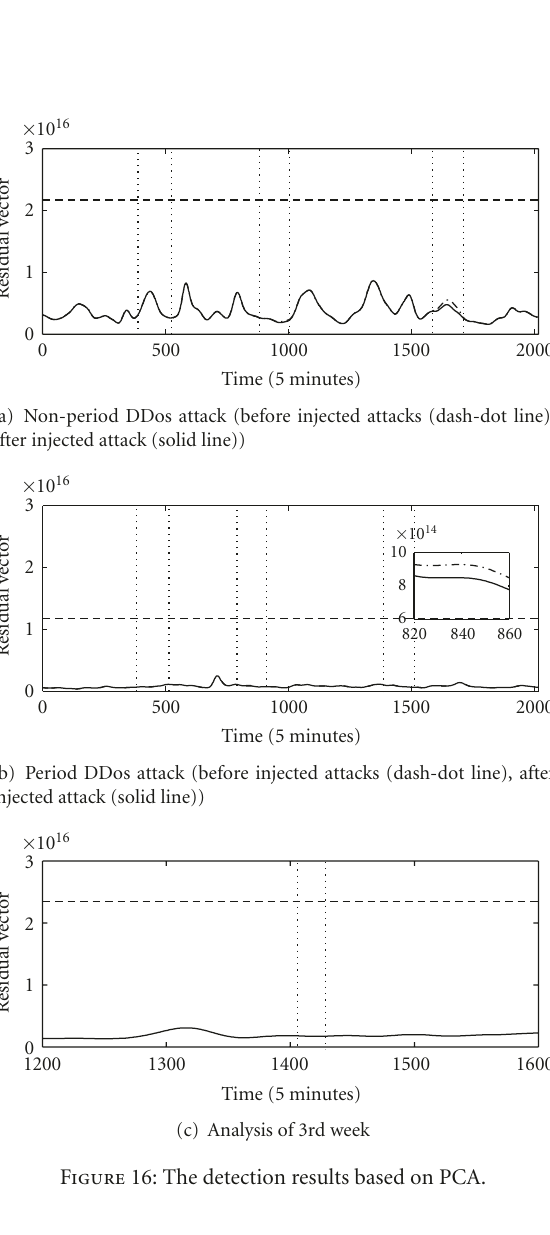
The residual part of real distributed anomalies in 3rd week separated by PCA is shown in Figure 16(c). As anomalies occurring (marked with vertical dotted lines ), the residual vector does not change obviously and retains lower than threshold (corresponding to horizontal dash line ). As a result, PCA-based method cannot reveal the anomalies which appear in multi OD flows